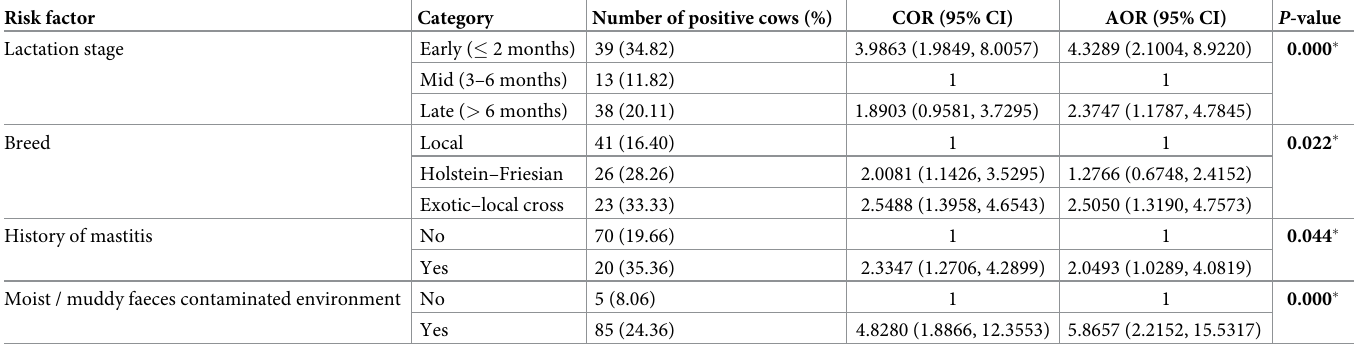
Table 6. Multivariate analysis of risk factors associated with coliform